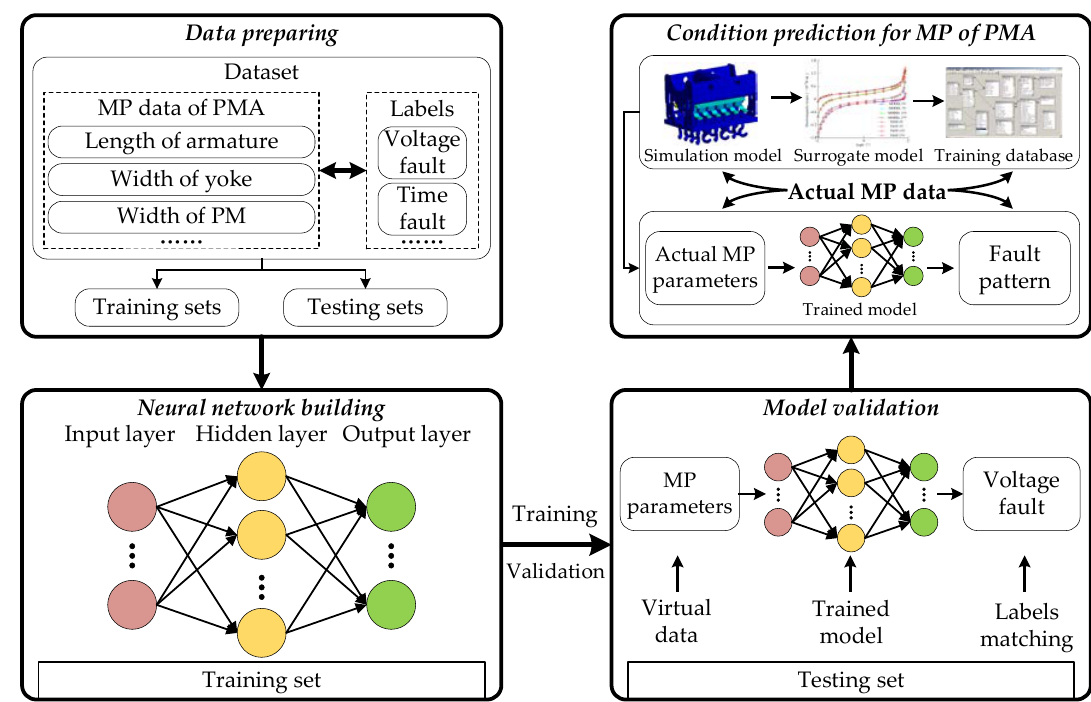
Figure 7. Fault diagnosis of the manufacturing process.